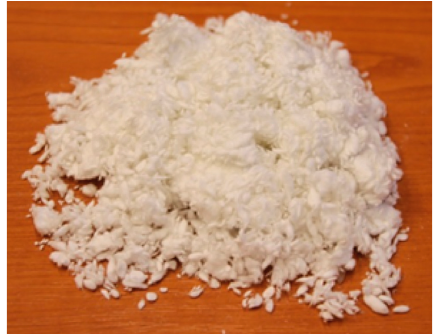
Figure 1: Studied ceramic fibers IZOWAT